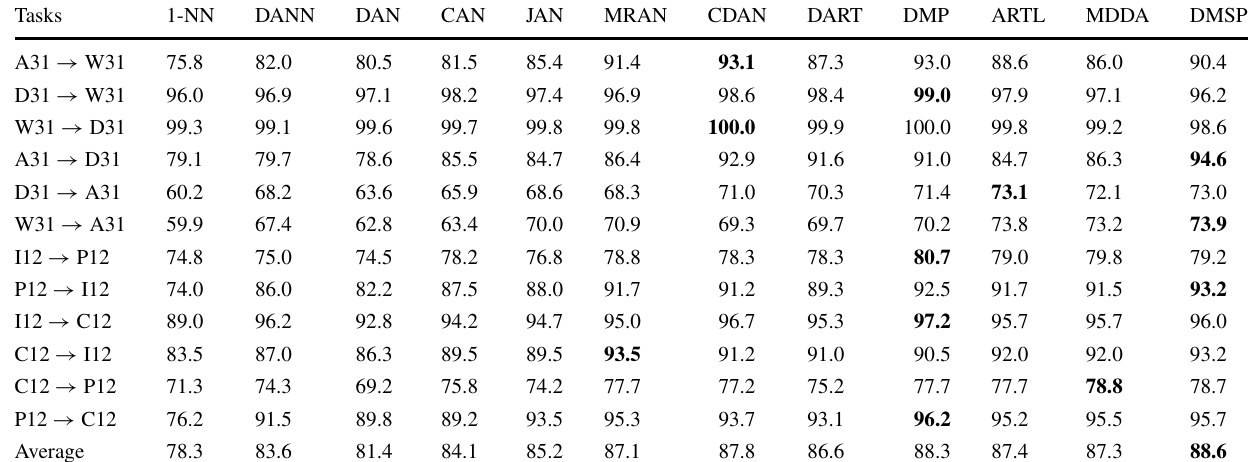
Table 4 Accuracy (%) on Office-31 and ImageCLEF-DA Tasks